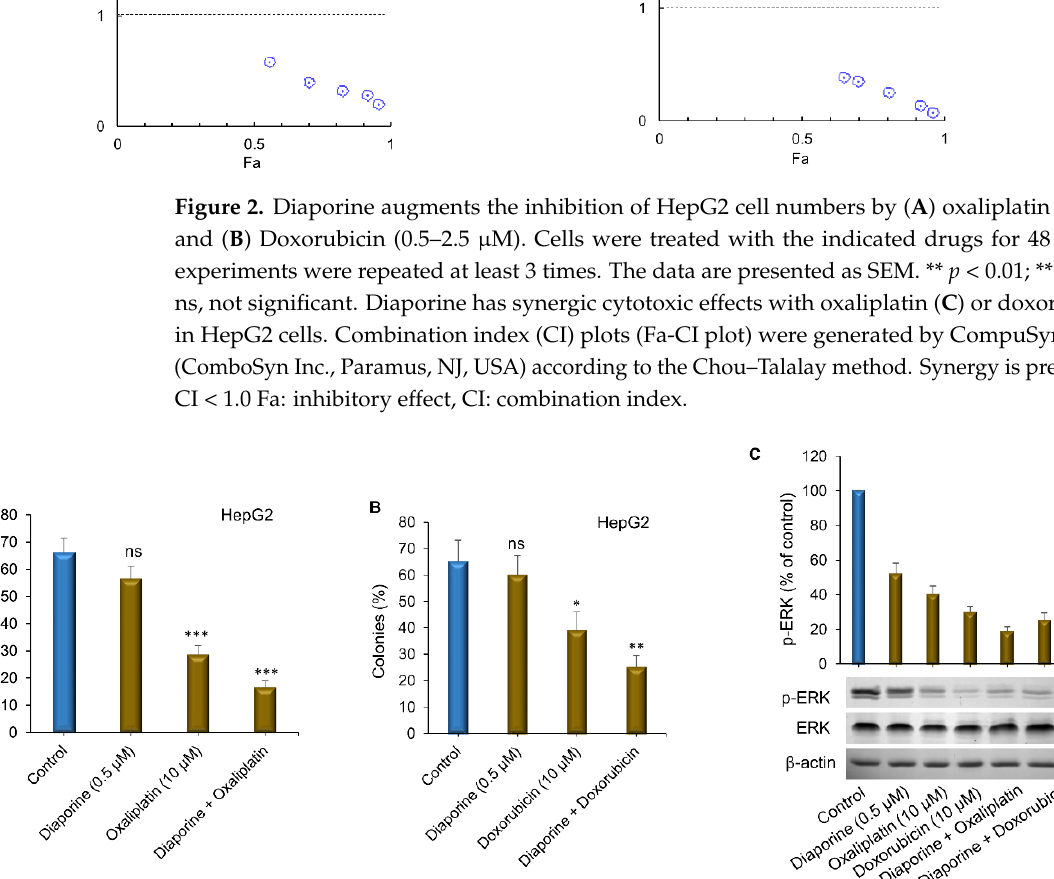
Figure 3. Diaporine enhances the inhibitory effects of ( A ) oxaliplatin (10 µ M) and ( B ) doxorubicin (10 µ M) on colony growth. The data are displayed as the mean percentage histogram of macrocolony growth ± SEM. ( C ) Diaporine can enhance the inhibition of oxaliplatin and doxorubicin on ERK phosphorylation in HepG2 hepatoma cells. Densitometry analysis of p-ERK from 3 independent experiments (upper panel). B-actin was used as an internal control at protein level. * p < 0.05; ** p < 0.01; *** p < 0.001; ns, not significant.